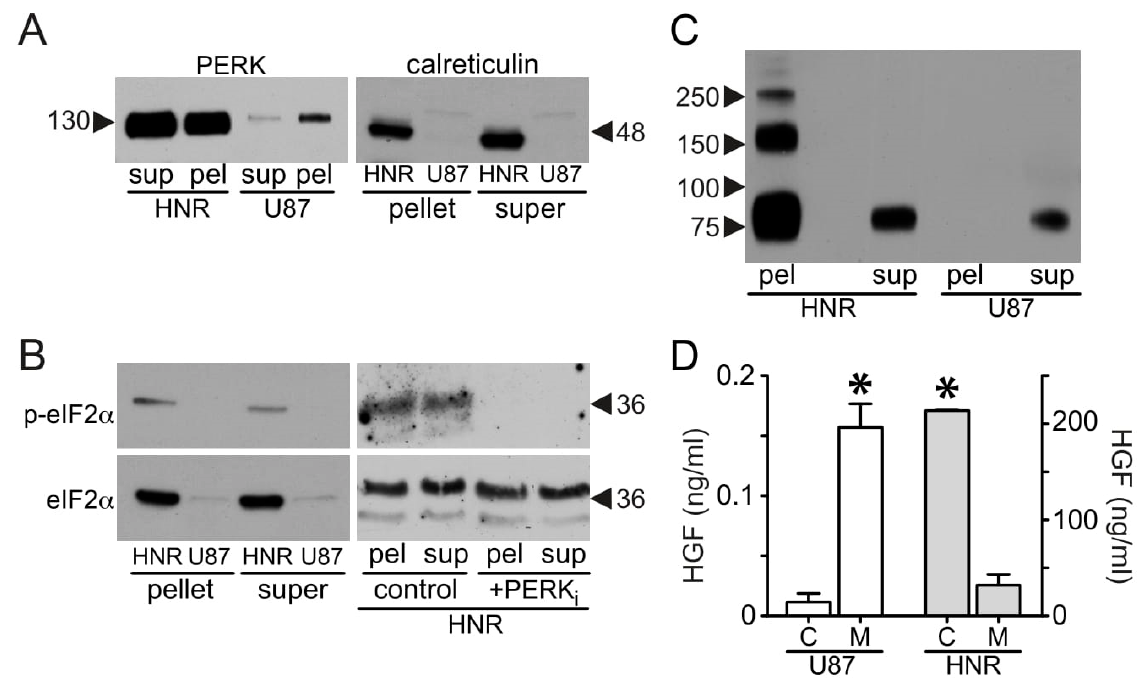
Figure 8. Acquisition of ER stress through HGF protein misfolding in U87 MG/HNR. ( A ) Reduced SDS-PAGE and immunoblot analysis of U87 MG (“U87”) and U87 MG/HNR (“HNR”) cell extracts for PERK (left panel) and calreticulin (right panel). Cells were extracted with ice-cold buffer containing TX-100 detergent, protease and phosphatase inhibitors before centrifugation to separate soluble (“sup”, left, or “super” right) and insoluble (“pel”, left, or “pellet”, right; these abbreviations also apply to panels ( B , C )) cell fractions; insoluble fractions were subsequently solubilized in buffer containing 1% SDS prior to analysis. ( B ) Left, reduced SDS-PAGE and immunoblot analysis of U87 MG (“U87”) and U87 MG/HNR (“HNR”) TX-100 cell extracts for phospho-EIF2a (“p-eIF2a”; upper panels) and total EIF2 α (lower panels); as in panel ( A ), TX-100 extracts were separated into soluble and insoluble fractions prior to analysis. Right, reduced SDS-PAGE and immunoblot analysis for phospho-EIF2a (upper panel) and total EIF2 α (lower panel) for U87 MG/HNR (“HNR”) in the ab- sence (“control”) or presence (“+PERK i ”) of the selective PERK antagonist GSK2656157. As in panel ( A ), TX-100 extracts were separated into soluble and insoluble fractions prior to analysis. ( C ) Non- reduced (i.e., not treated with dithiothreitol or beta-mercaptoethanol so that disulfide bonds remain intact) SDS-PAGE and immunoblot analysis of U87 MG (“U87”) and U87 MG/HNR (“HNR”) cell TX100 extracts for HGF; as in panel ( A ), extracts were separated into soluble and insoluble fractions prior to analysis. ( D ) HGF protein concentration (ng/mL) in U87 MG cell (“U87”, white bars, left y- axis) lysates (“C”) and 24-h-conditioned media (“M”) and U87 MG/HNR cell lysate and media (“HNR”, gray bars, “C” and “M”, respectively, right y-axis). Mean values (ng/mL ± SD) from tripli- cate samples were normalized to total cell protein. Asterisks indicate a significant difference from control ( p < 0.05). All the whole western blot figures can be found in the supplementary materials. Most significant among the immune-related IPA canonical pathway changes ac- quired with rilotumumab resistance was “Antigen Presentation” (75% pathway overlap, B–H multiple test p = 1.74 × 10 − 3 , Table S3). We suspected that substantial alterations in vesicular trafficking might effectively partition rilotumumab away from HGF and Met. Because lipid rafts are critical for many vesicular traffic systems [49,50] and these choles- terol-rich lipid regions are usually insoluble in TX100 detergent, we performed a series of experiments analyzing TX100 detergent soluble and insoluble cell lysate fractions of the resistant and parental cell lines for HGF, Met, pMet and rilotumumab content. Consistent with a role in acquired resistance, the rate of rilotumumab uptake by U87 MG/HNR was over 28-fold higher than that of the parental cells under identical conditions (Figure 9A). Moreover, whereas nearly all (88%) of the antibody taken up by the parental cell line was